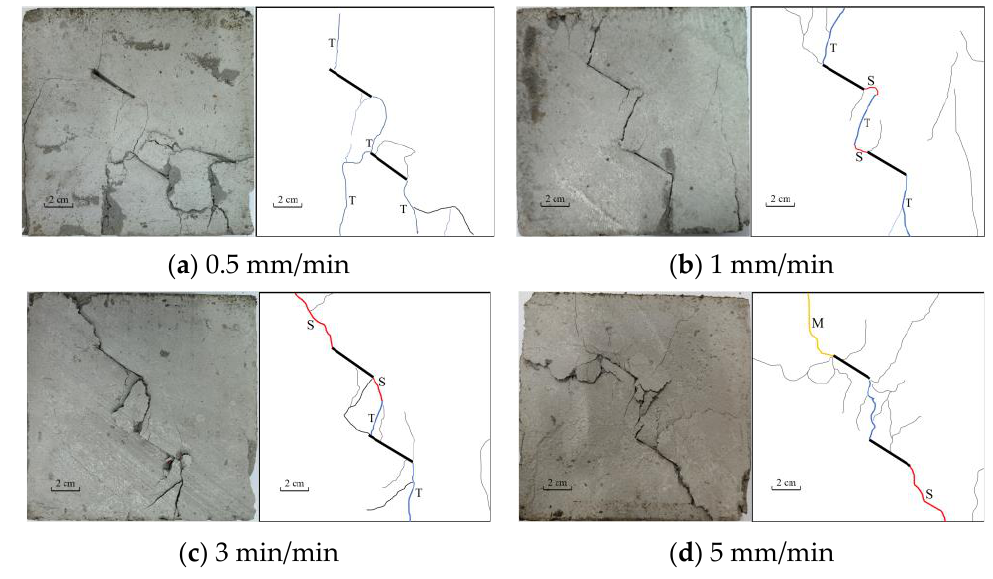
Figure 4. Crack development diagram of crack specimen under uniform loading.